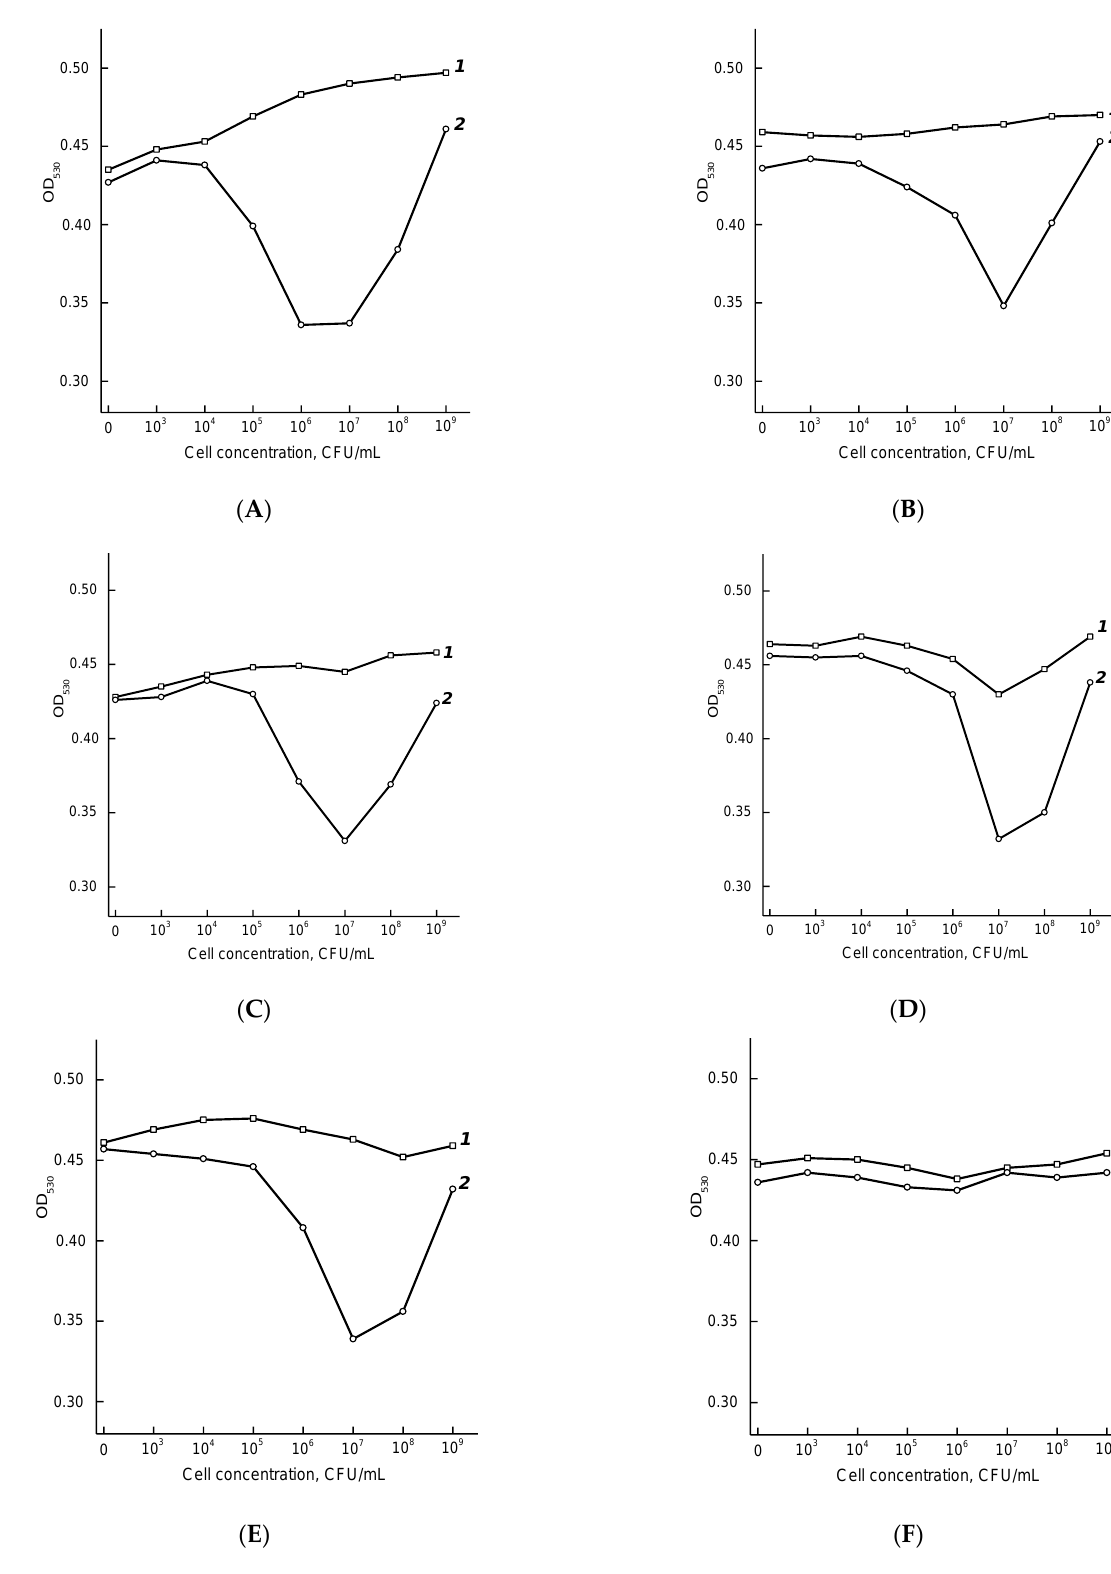
Figure 4. Agglutination of AuNPs2 – Fb11 conjugate in the presence of various concentrations of thermally inactivated F. tularensis subsp. holarctica 15 NIIEG ( A ) and 503 ( B ), F. tularensis subsp. mediasiatica 120 ( C ), F. tularensis subsp. tularensis Schu ( D ) and A-Cole B-399 ( E ), and F. tularensis subsp. novicida Utah112 ( F ). Curves 1 and 2 correspond to 1 and 20 min of the reaction.